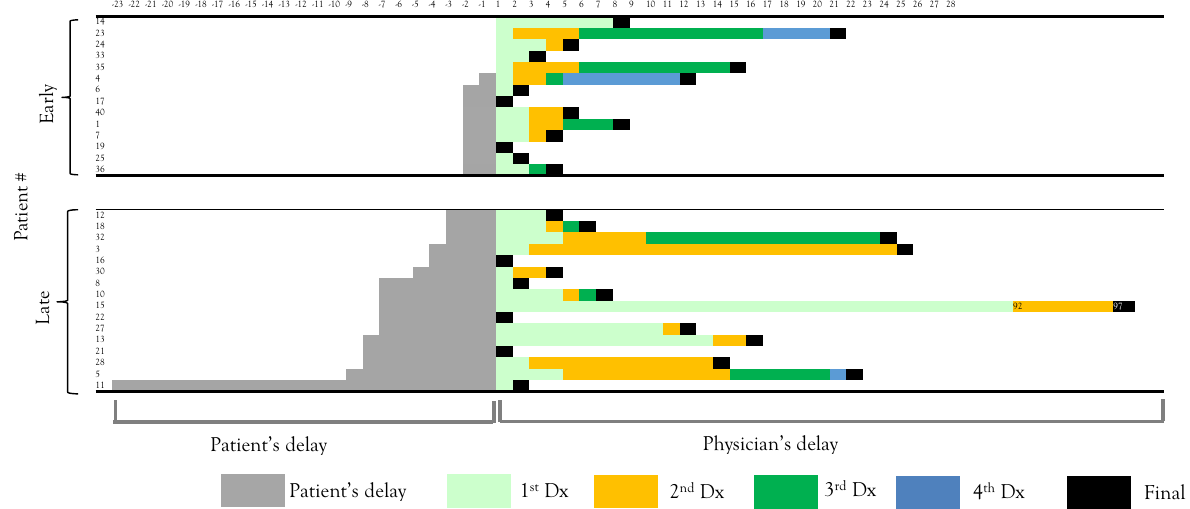
Figure 4. Patient attendance and diagnostic delay in paediatric ADEM. Each column shows the diagnostic odyssey plot of each ADEM case. Cases are placed in ascending order of their patient attendance delay. Patient early-attended cases are those attended ≤ 4 days after symptom onset. ADEM acute disseminated encephalomyelitis.